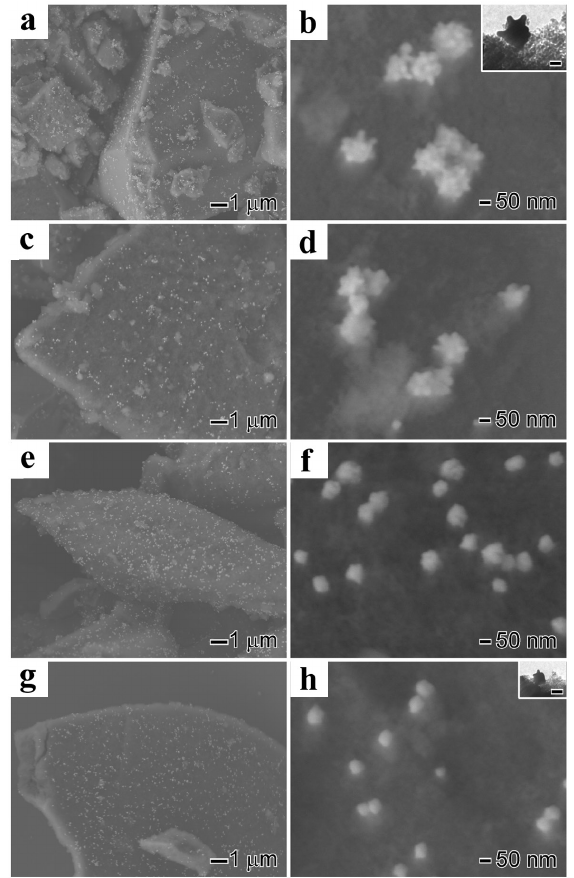
Figure 16 - SEM images of AgAu nanodendrites with controlled surface morphologies supported on commercial SiO (AgAu/SiO ) by wet impregnation. The average sizes of 2 2 the AgAu nanodendrites corresponded to: ( a and b ) 148 ± 6 nm, ( c and d ) 96 ± 5 nm, ( e and f ) 66 ± 4 nm, and ( g and h ) 45